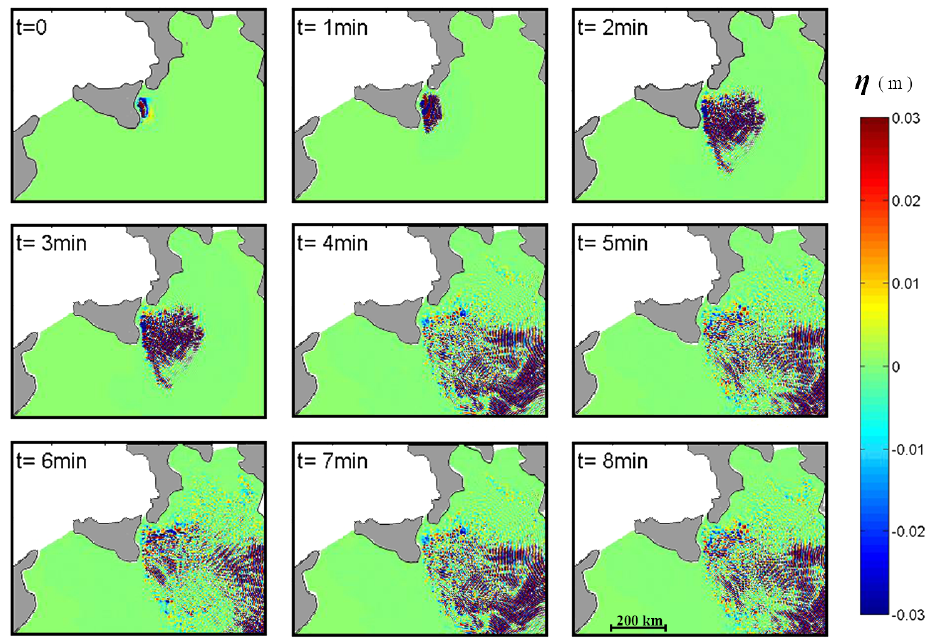
Figure 10. Snapshots of the free surface ( η ) hydro-acoustic perturbation given by the 1693 Catania (Sicily) earthquake. t = 0 refers to the time of occurrence of the earthquake.